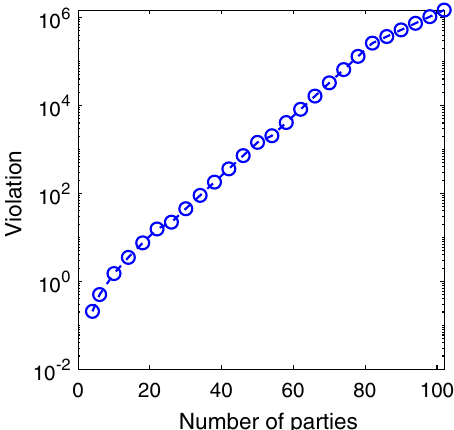
FIG. 14. Quantum nonlocality violation of the Svetlichny box for number of parties ¼ 4 ; 8 ; 12 ; … ; 102 . Maximum bond dimension ¼ ð 4 4 Þ . The violations are obtained using the seesaw optimization scheme. We use the optimized connectors for L − 4 parties as the initial guess for connectors for L parties.